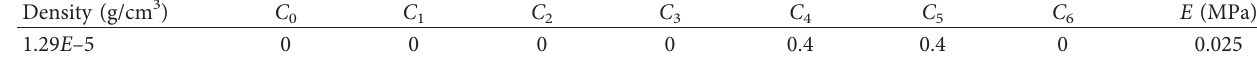
Table 3: Air material and its equation of state parameters.